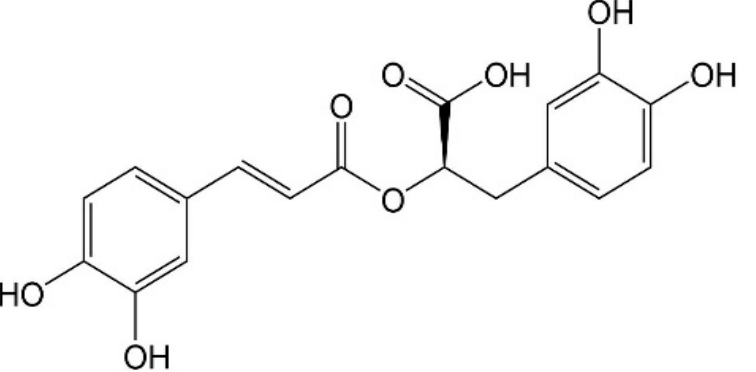
Figure 1. Chemical structure of Rosmarinic acid (RA).